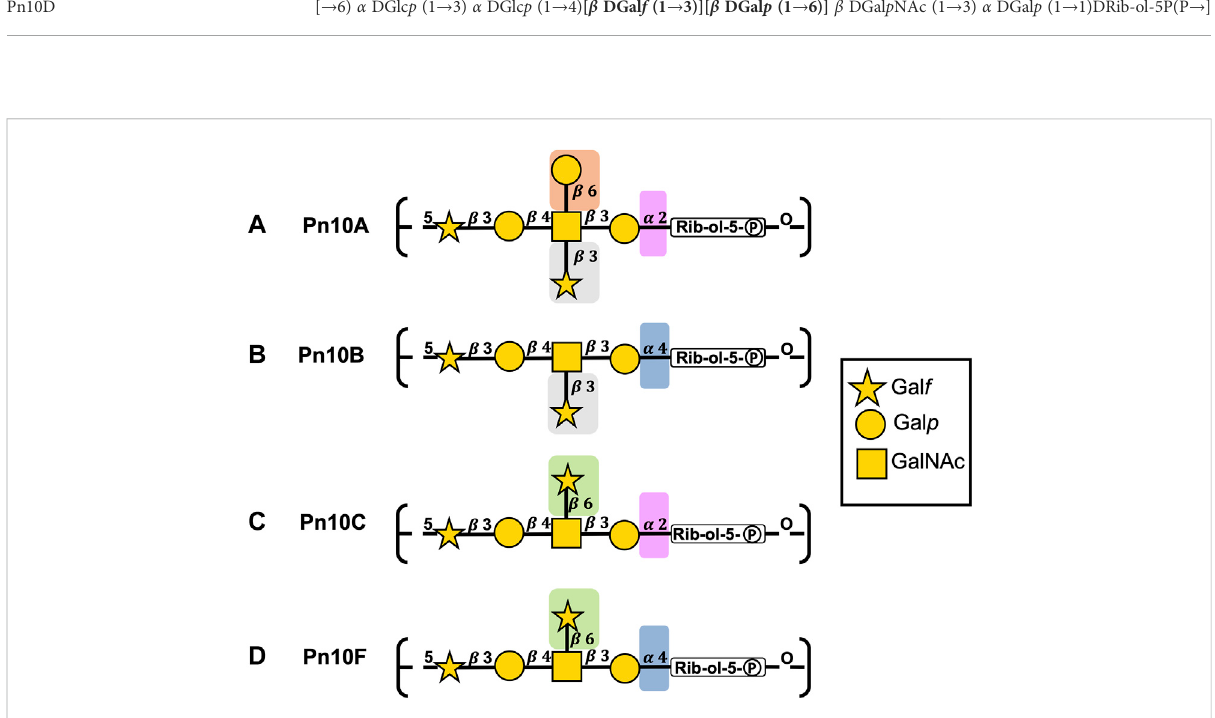
FIGURE 2 S. pneumoniae serogroup 10 CPS repeating unit structures for (A) Pn10A, (B) Pn10B, (C) Pn10C, and (D) Pn10F represented with the SNFG (Symbol Nomenclature for Glycans) system (Varki et al., 2015). Similarities and differences in repeating units are indicated by background color